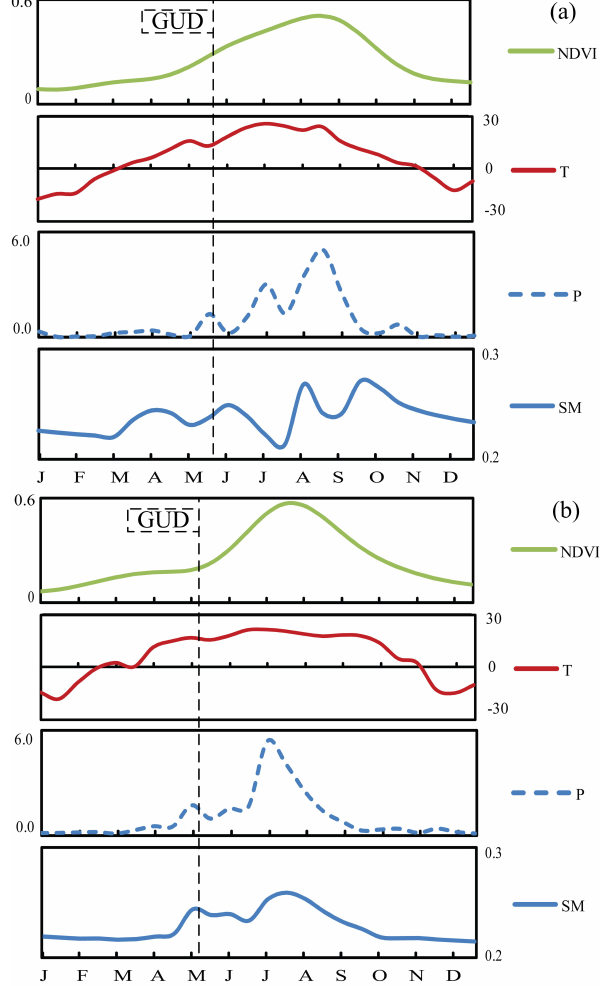
Fig. 8. Annual series of NDVI, simulated soil moisture, precipita- tion and air temperature of 1997 (a) and 1998 (b) at station num- ber 10 (the captions J to D in the x-axis stands for January to